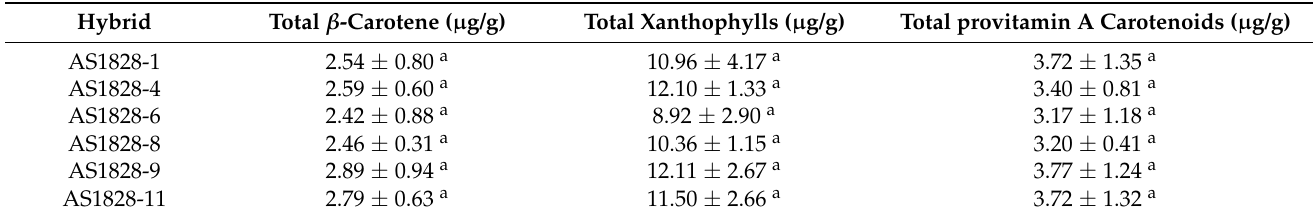
Table 2. Carotenoid content of six pipeline Striga -resistant yellow-orange maize